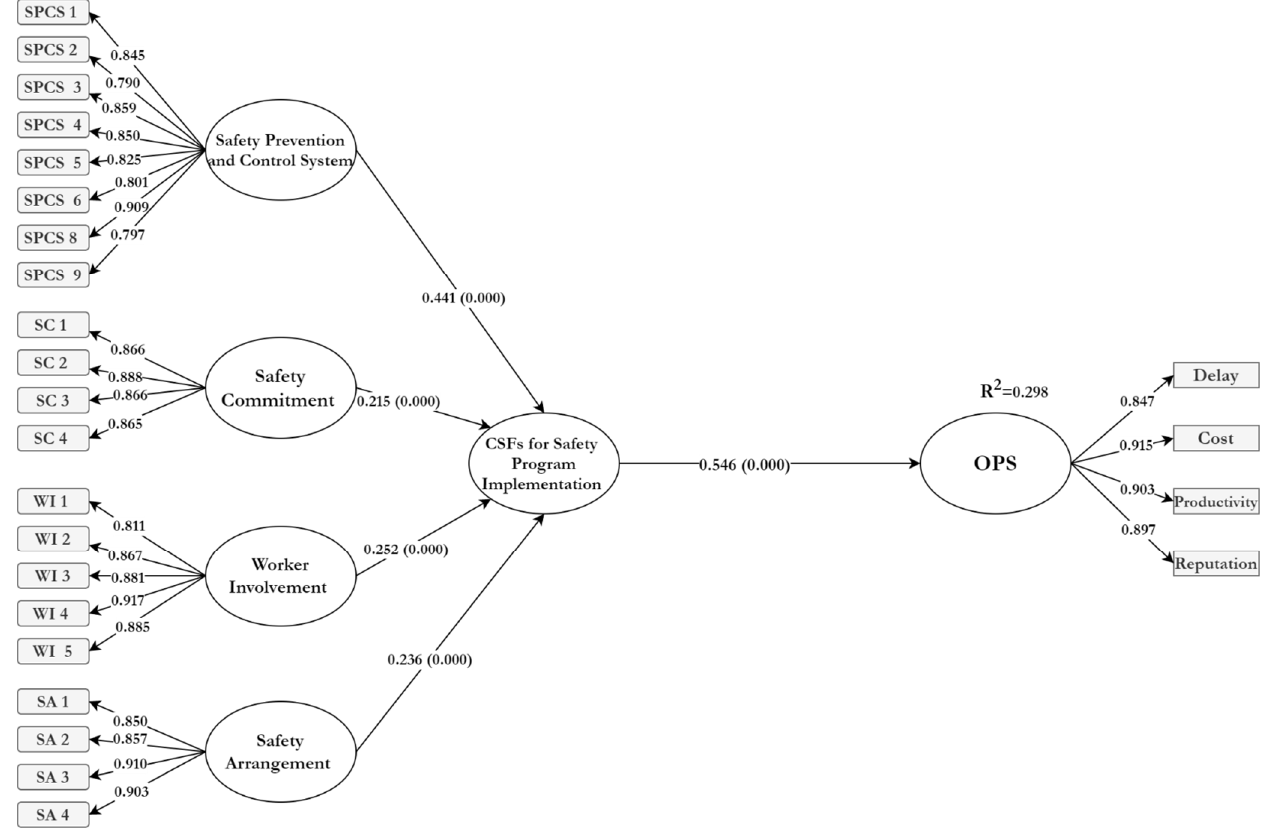
Figure 3. Structural Model.